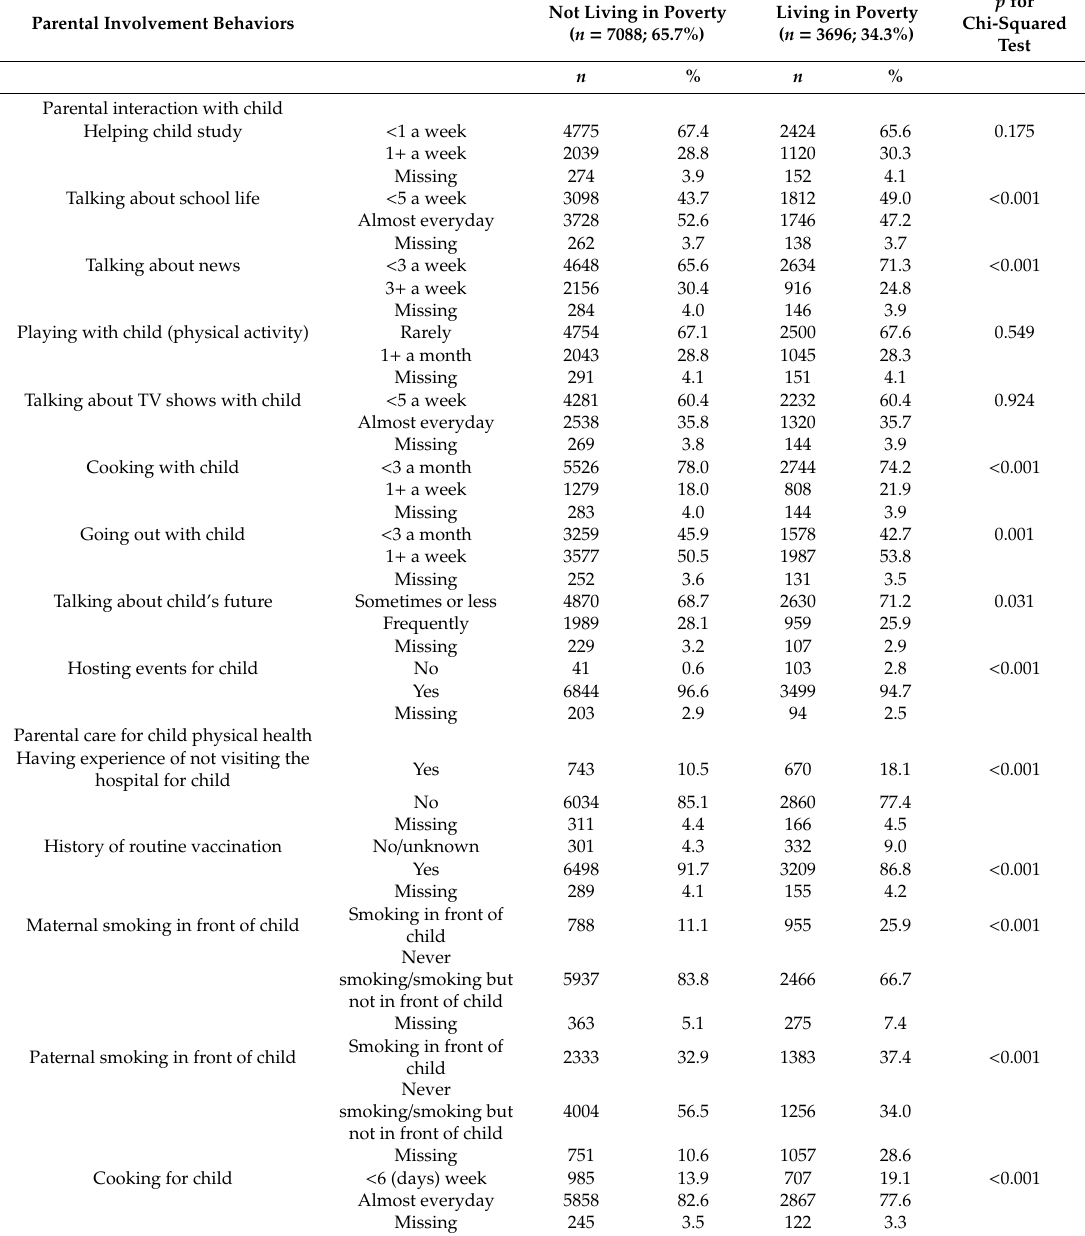
Table 2. Parental involvement behaviors among adolescents living in poverty and not living in poverty ( n = 10,784). Parental Involvement Behaviors